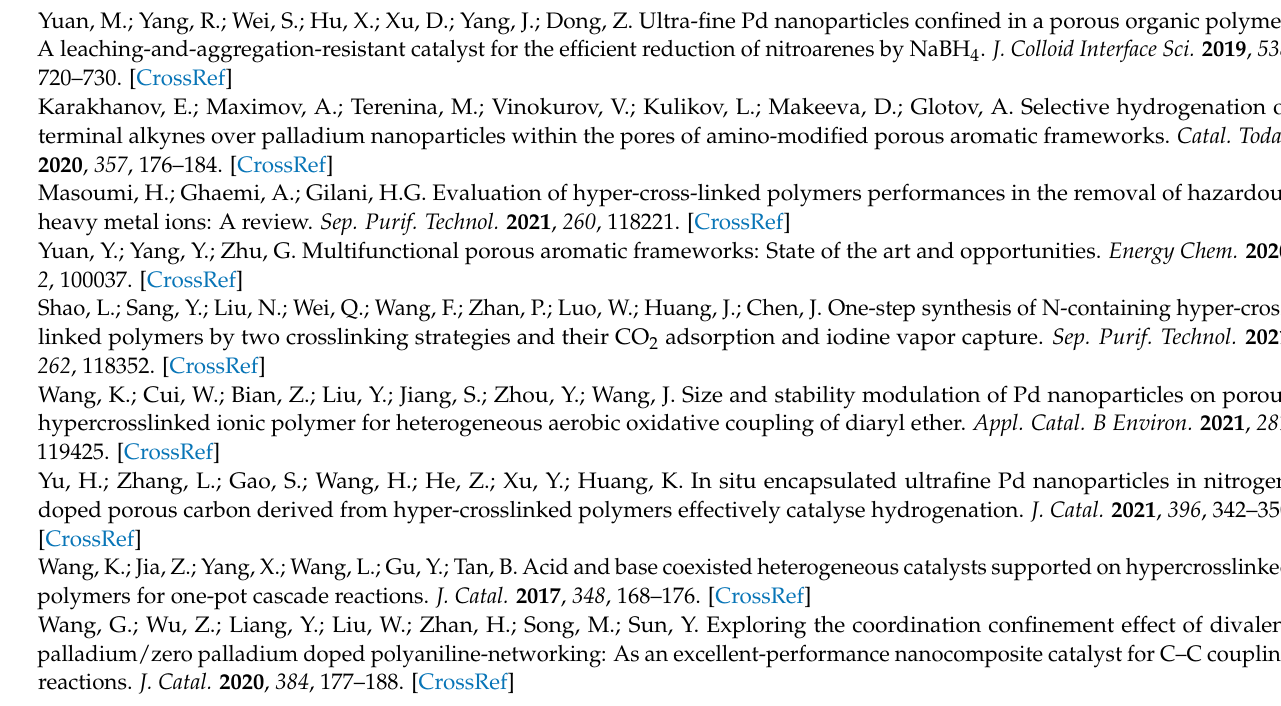
image, Figure S3: High-resolution XPS spectra of Au 4f (a), Cu 2p (c), Zn 2p (e) and Pd 3d (b,d,f) in the initial (unreduced) samples: 1%-PdAu/HPS(a,b), 1%-PdCu/HPS(c,d) and 1%-PdZn/HPS(e,f), Figure S4: High-resolution XPS spectra of Au 4f (a), Cu 2p (c), Zn 2p (e) and Pd 3d (b,d,f) in the reduced samples: 1%-PdAu/HPS-R (a,b), 1%-PdCu/HPS-R(c,d) and 1%-PdZn/HPS-R (e,f), Figure S5: Influence of stirring rate on the dependence of BrAn conversion vs. time for 1%-Pd/HPS-R (catalyst loading 30 mg, 1 mmol of BrAn, 1.5 mmol of PBA, 1.5 mmol of NaOH, 60 ◦ C), Figure S6: Influence of catalyst 1%-Pd/HPS-R loading on the dependence of BrAn conversion vs. time (1 mmol of